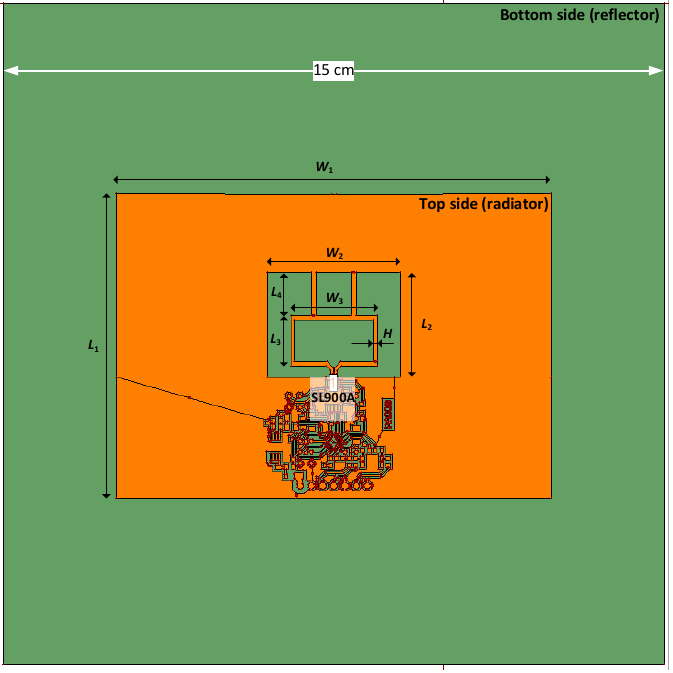
Table 1. Dimensions of designed antenna in accordance with designations in Figure 6.